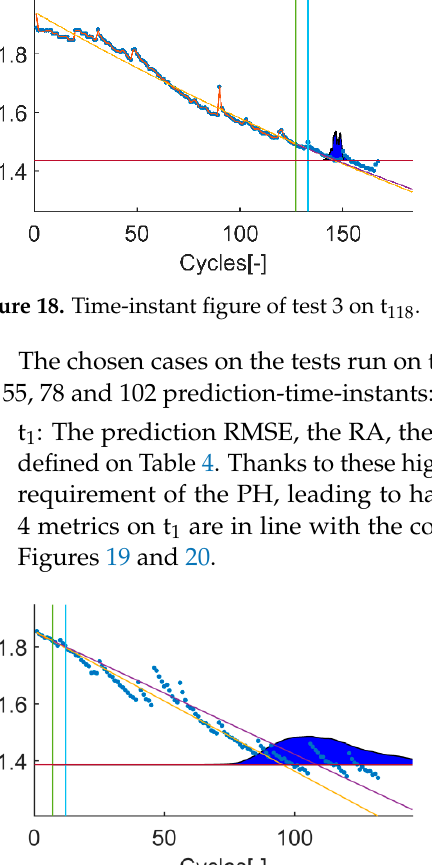
21 of 28 Figure 15. Time-instant figure of test 1 on t 65 . Figure 16. Time-instant figure of test 3 on t 65 .  t 118 : The RA and the P width are the same on both cases but the prediction RMSE and the P value are worse in test 1. This means that the test 3 has a higher probability of predict- ing the real RUL and that tracks better the nearest trend. The exponential model de- scribes better the trend underneath the data, see Figures 17 and 18.